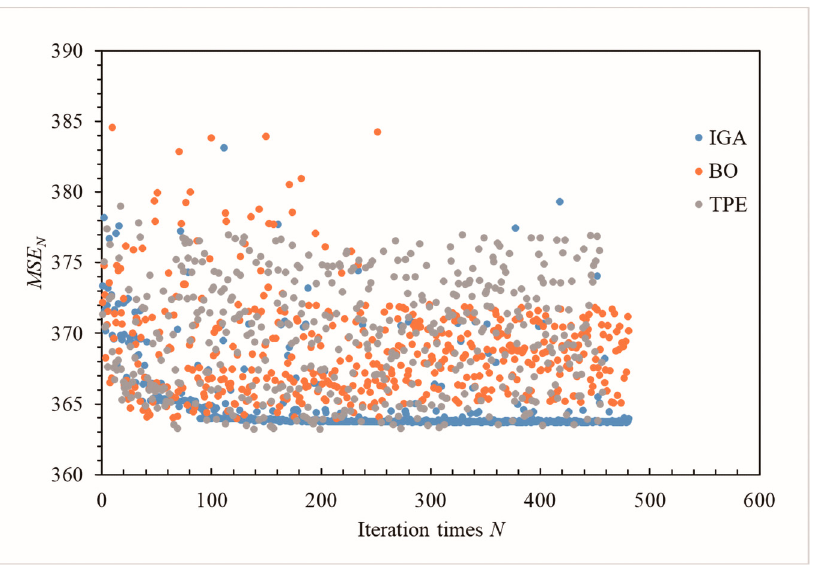
Figure 10. Comparison of the three algorithms for the inversion of the dam foundation’s hydraulic conductivity.